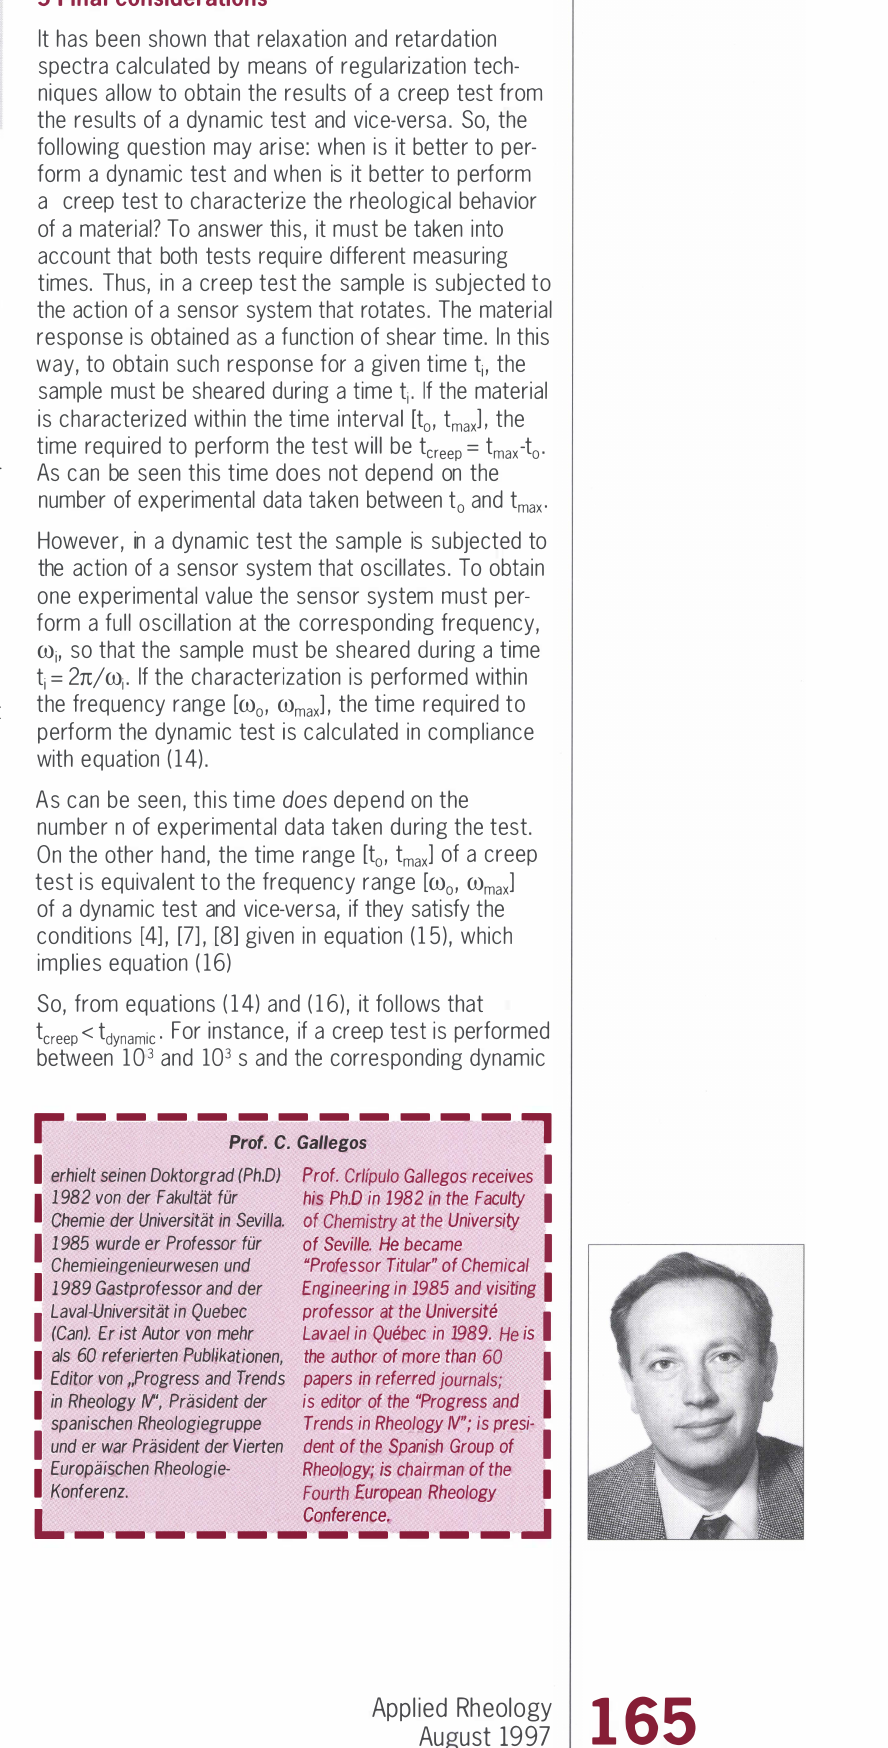
Fig. 6: Experimental values of the creep compliance, and recalculated values from the retardation spectrum obtained from dynamic tests, for the different